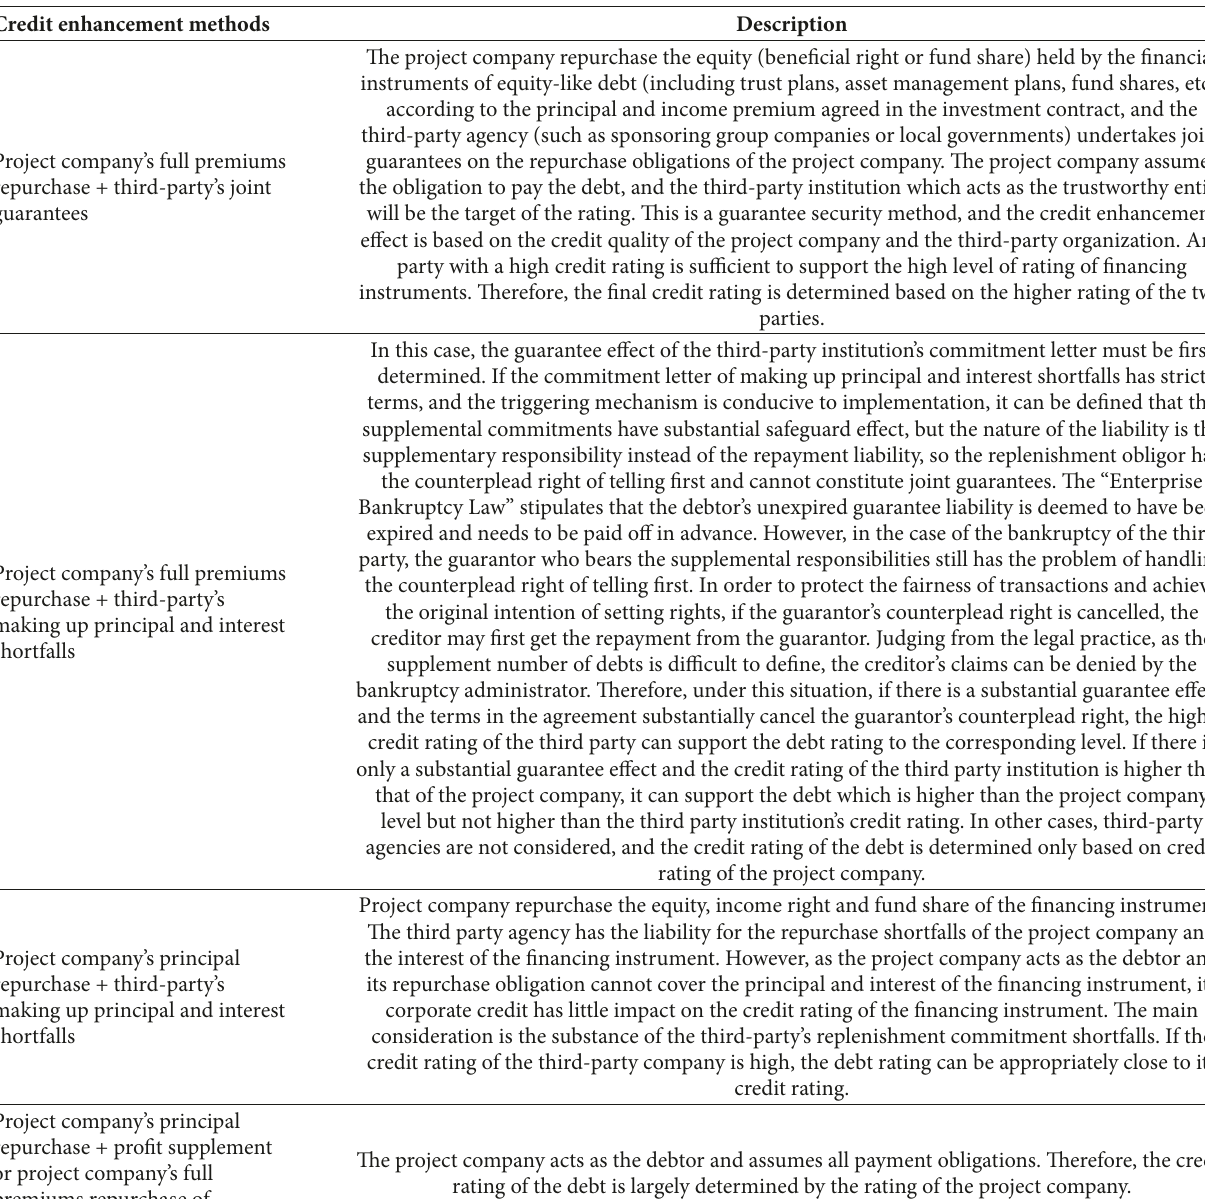
Table 2: The description of four main credit enhancement